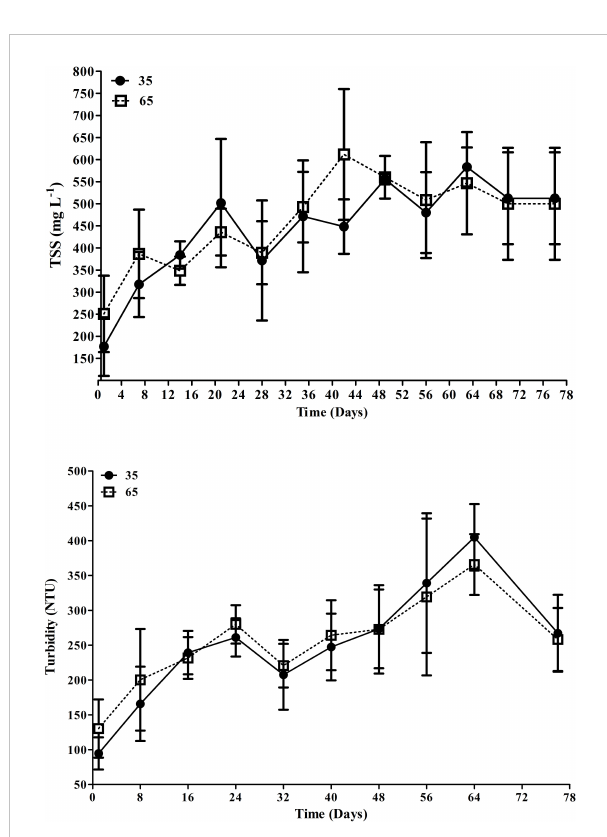
FIGURE 3 Mean TSS (total suspended solids) concentrations (mg L -1 ) and turbidity (NTU) in T35 and T65 treatments during the 78 days of experiment. Data are presented as mean ± standard